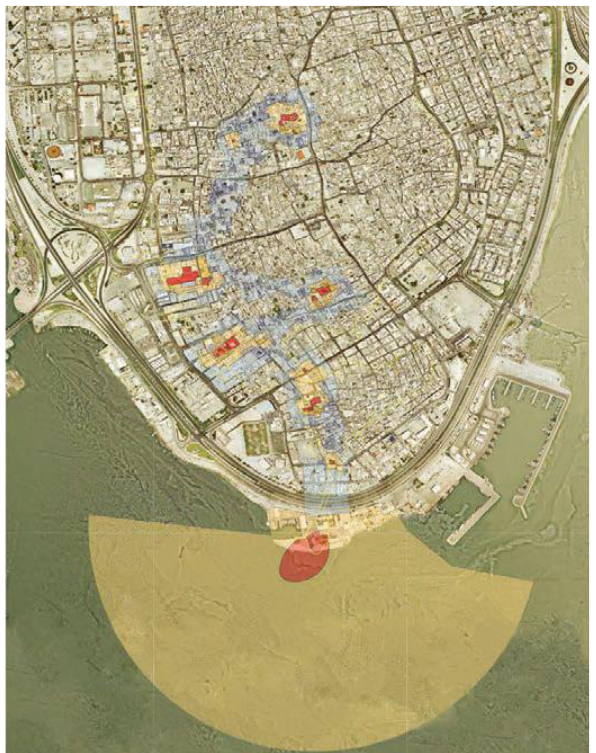
Figure 3 Map of the Muharraq inscribed properties and their buffer zone. Image source (Kingdom of Bahrain Ministry of Culture & Information, 2012).